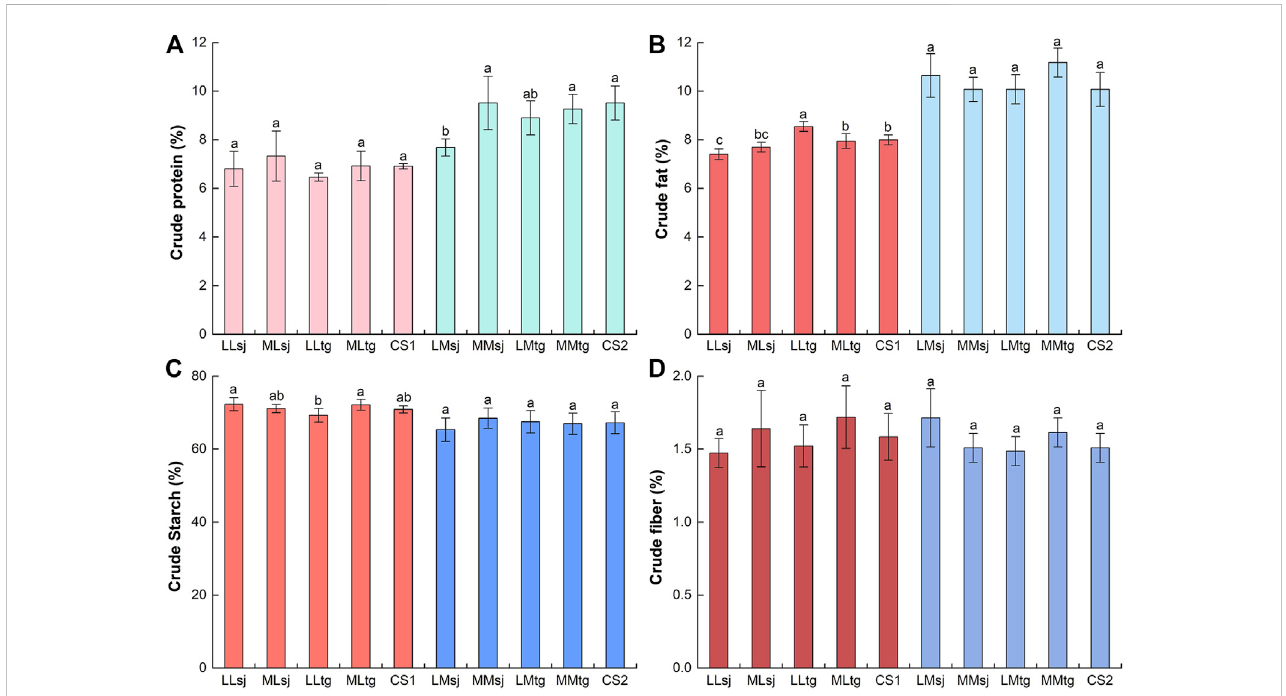
FIGURE 5 Grain quality in different treatments. (A) , crude protein; (B) , crude fat; (C) , crude starch; (D) , crude fi ber. Error bars represent standard deviations ( n = 3), different letters in the same row indicated signi fi cant difference among the treatments at 0.05. Note: LLsj, MLsj, LLtg, MLtg, CS1, LMsj, MMsj, LMtg, MMtg, and CS2, same to the above explanations.